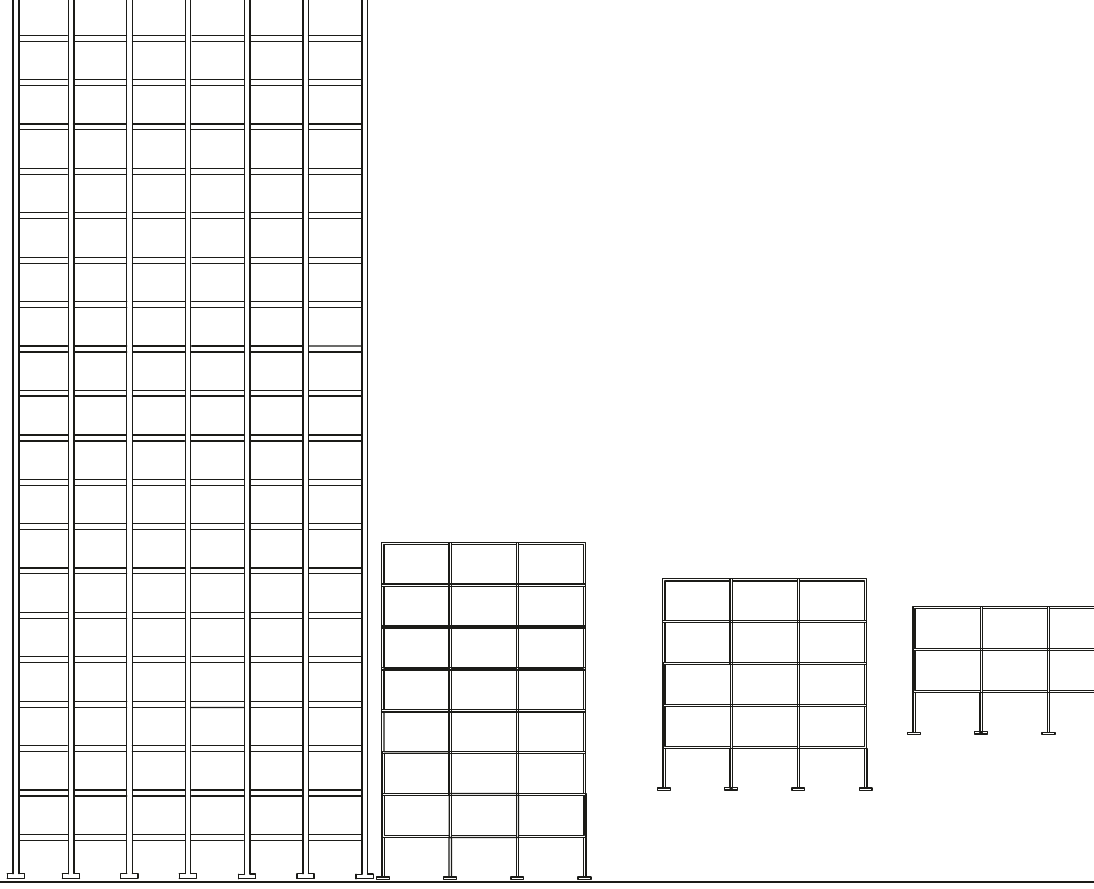
Figure 1: Topology of 20-, 8-, 5-, and 3-story